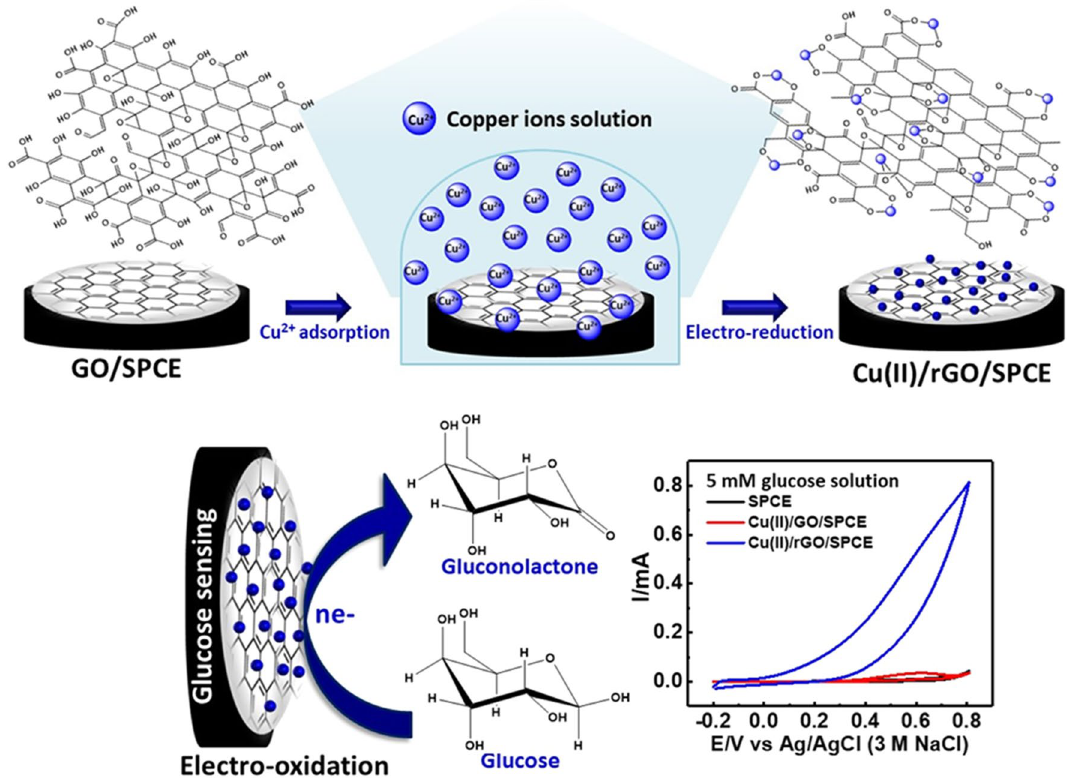
Figure 1. Schematic illustration. Fabrication of non-enzymatic glucose sensor based on the Cu(II)/rGO nanocomplex-modified SPCE and its application in glucose